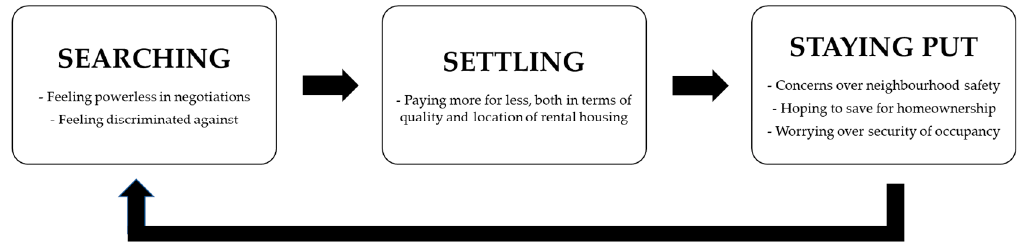
Figure 1. The cycle of rental insecurity for younger tenants with